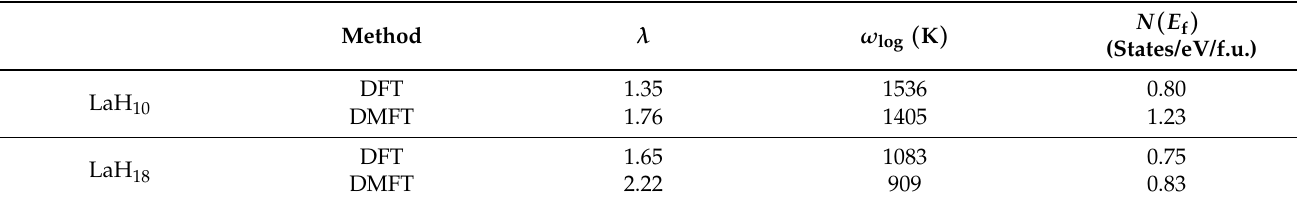
Table A2. Calculated variation of λ , ω log and N ( E f ) for LaH 10 and LaH 18 compounds in Fm-3m and Fmmm phase at 400 GPa,